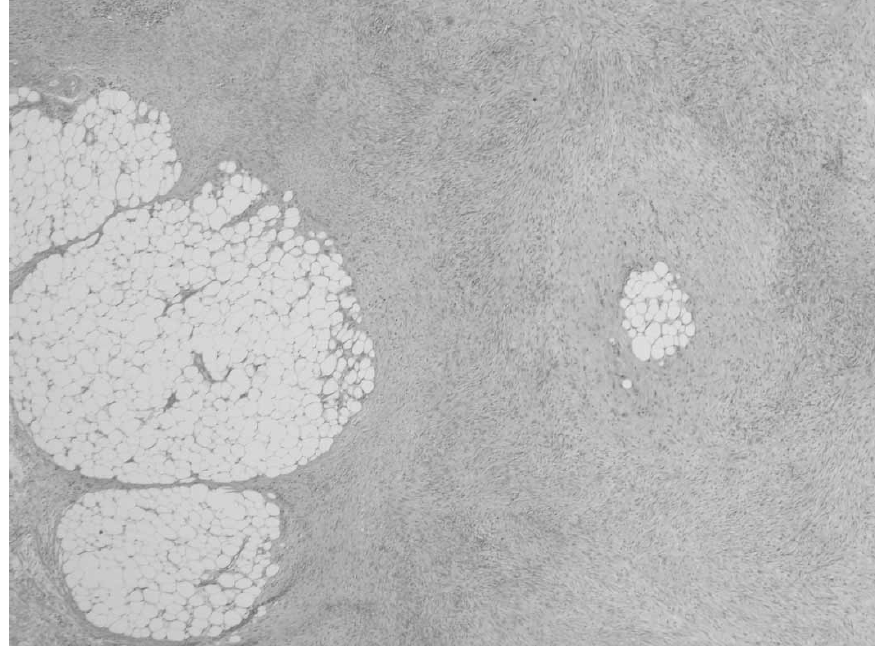
Fig. 4. Long fascicles of spindle cells infiltrating underlying adipose tissue from the retroperitoneal biopsy consistent with intra-abdominal fibromatosis.